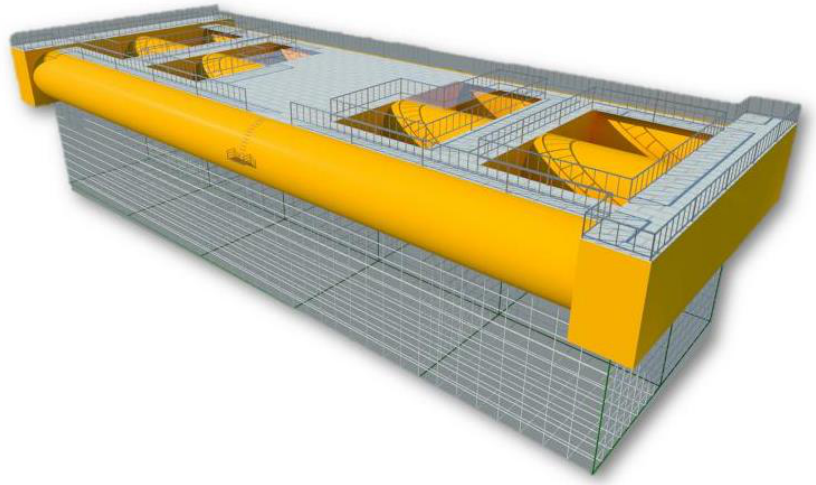
Figure 1. Three-dimensional diagram of the three-cylinder floating breakwater.